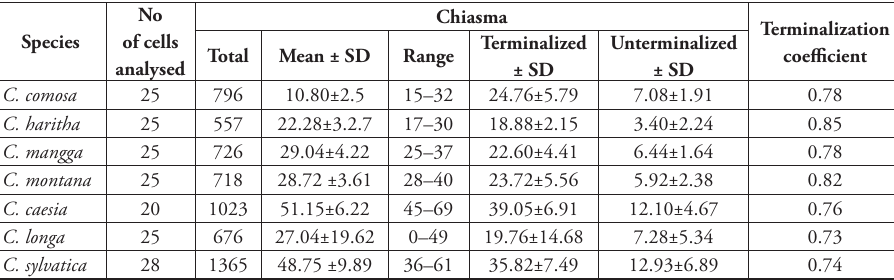
Table 2. Mean number and range of chiasma, terminalization coefficient and percentage of pollen stain- ability in Curcuma